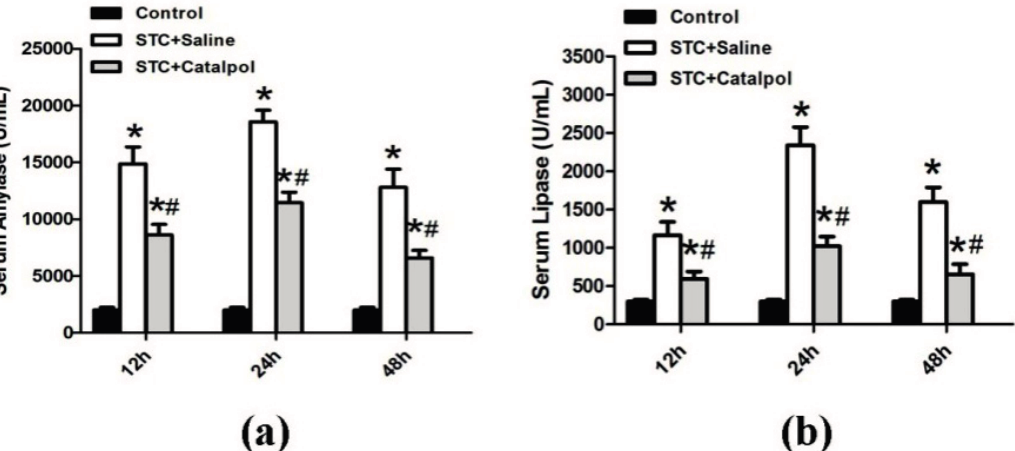
Figure 2. AP was induced in rats ( n = 12 in each group) by treatment with 4% STC. Saline or catalpol (50 mg/kg) was administered 2 h before STC injection. The control group was administered saline (0.9% NaCl) instead of STC. Rats were sacrificed 12, 24 and 48 h after STC injection. Four rats were examined at every time-point in each group. Blood samples were collected, and activities of serum amylase ( a ) and lipase ( b ) were measured. Data are presented as means ± SD of three independent experiments. * p < 0.05, compared with the control group at the same time-point; # p < 0.05, compared with the STC + saline-treated group at the same